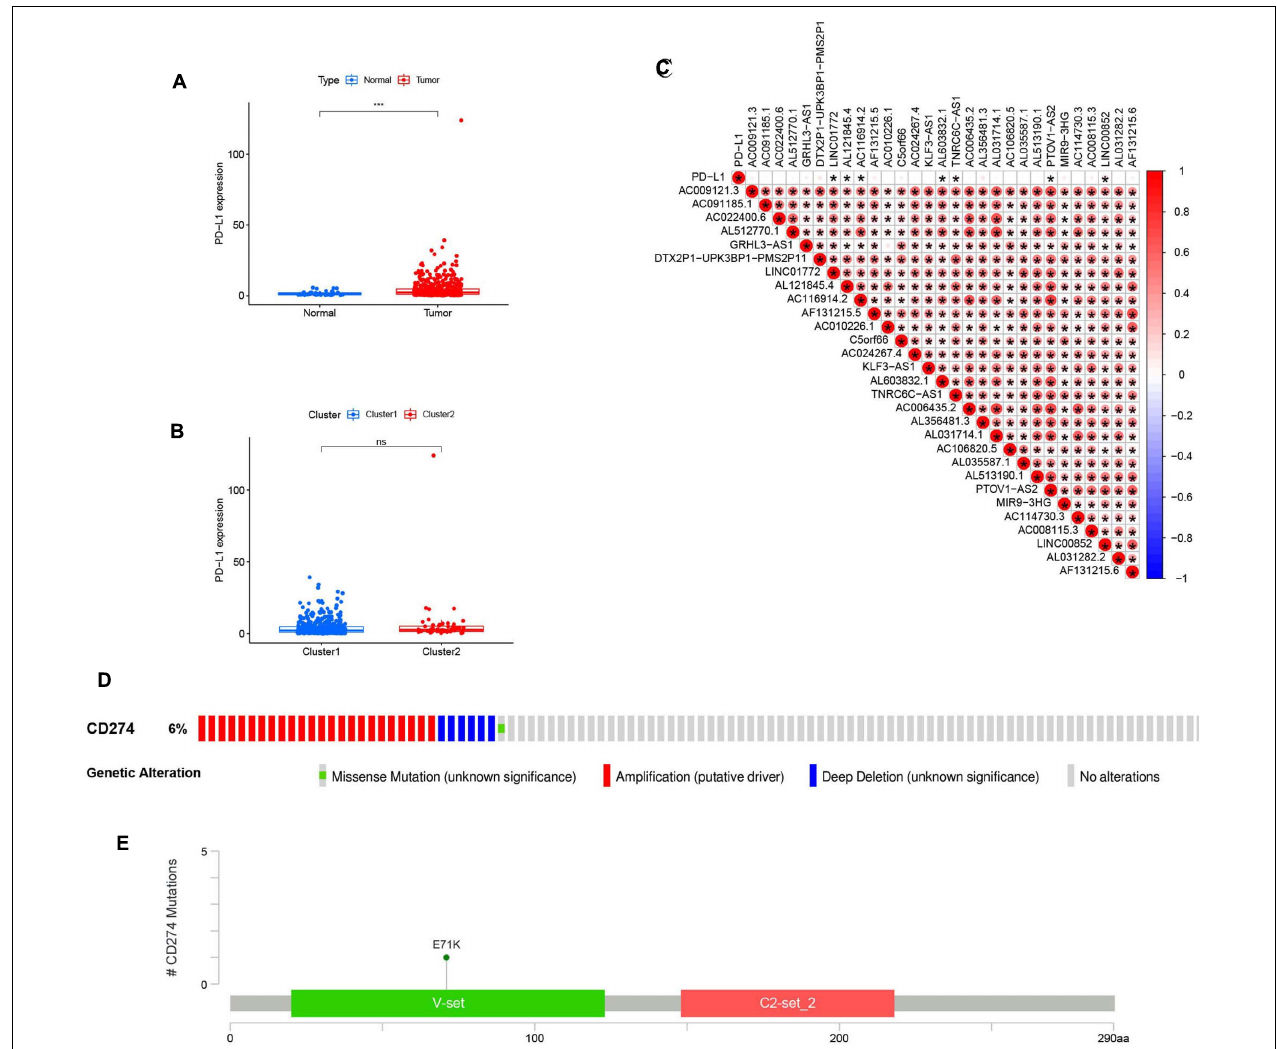
FIGURE 6 | Association of PD-L1 with m 6 A RNA methylation-related IncRNAs. (A) PD-L1 upregulation in HNSCC in TCGA cohort, P < 0.001 (“***”). (B) The expression level of PD-L1 in clusterl/2 subtypes in TCGA cohort. (C) The expression correlation of the m 6 A RNA methylati on-related IncRNAs and PD-L1, the red circle represents a positive correlation. P < 0.05 (“*”). (D) OncoPrint of PD-L1 alterations in HNSCC cohort identified by cBioPortal. (E) Lollipop of PD-L1 alterations in HNSCC cohort